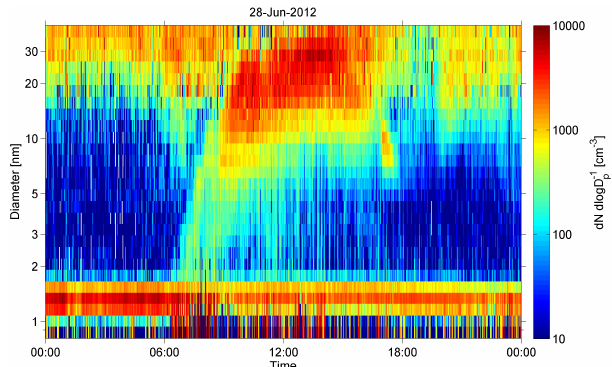
Figure 5. The size distribution of positive ions on a typical new particle formation event day at the San Pietro Capofiume station (28 June